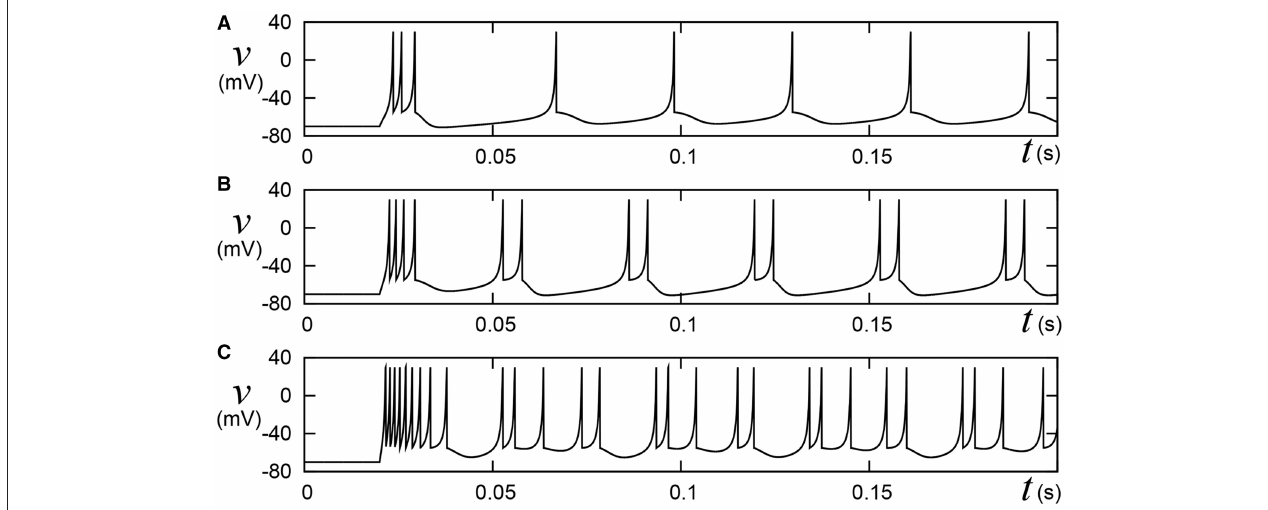
FIGURE 1 | Behaviors of the Izhikevich model in the IB class. Stimulus step input I stim rise at t = 0.02 , where (A) I stim = 10 , (B) 15 , and (C) 30 , respectively. A numerical integration step dt is 0.05